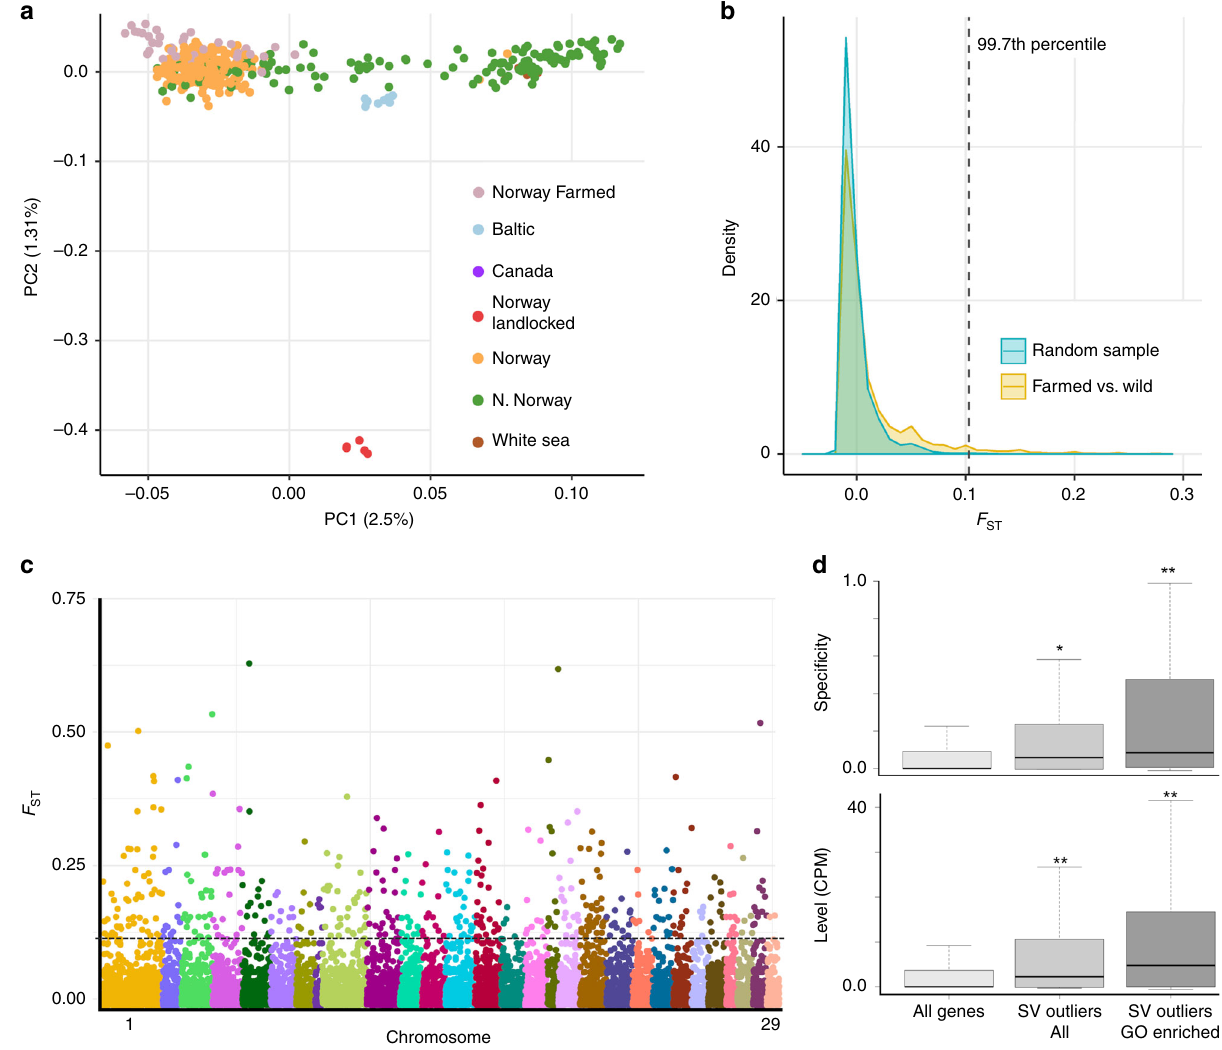
Fig. 3 Genetic differentiation of SVs between farmed and wild Atlantic salmon. a PCA used to select appropriate wild individuals for F ST comparison ( n = 257) vs. farmed salmon ( n = 34) on the basis of genetic distance by latitude (see also Supplementary Fig. 15) separated along PC1. The population symbols are the same as shown in Fig. 1. b Observed F ST value distribution comparing farmed vs. wild salmon contrasted against 200 random distributions for the same number of individuals. Dotted line shows cut-off F ST value employed in addition to a per SV criteria of P < 0.01. c Manhattan plot of 12,627 F ST values with dotted line showing the same cut-off above which are the 584 SV outliers. d Brain gene expression speci fi city (top panel) and expression level (bottom panel) are increased compared to global expectations for genes linked to the 584 outlier SVs, with the effect pronounced for a 326 gene subset contributing to signi fi cantly enriched GO terms. Hypergeometric tests were performed to compare the proportion of genes showing brain expression speci fi city ≥ 0.50 between 44,469 genes detected in a multi-tissue transcriptome vs. (i) the 584 gene subset (all SV outliers) (single asterisk indicates P = 0.0041) and (ii) the 326 gene subset (SV outliers GO enriched) (double asterisk indicates P = 2.42e − 07). Two-sample t -tests were used to compare the brain expression level (CPM) among the same 44,469 global gene set vs. (i) the 584 gene subset (all SV outliers) (double asterisk indicates P = 4.84e − 07) and (ii) the 326 gene subset (SV outliers GO enriched) (double asterisk indicates P = 6.65e − 07). The observed increase in expression was speci fi c to brain (plots for other tissues shown in Supplementary Figs. 22 and 23). Results of statistical analysis for all tissues are shown in Supplementary Data 15. A de fi nition of the box and whisker plots can be found in the Fig. 1a